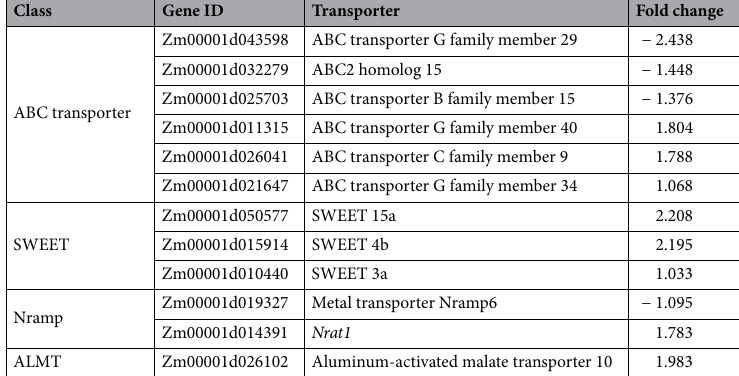
Table 1. Aluminum responsive transporters related to Al-sensitive inbred line.